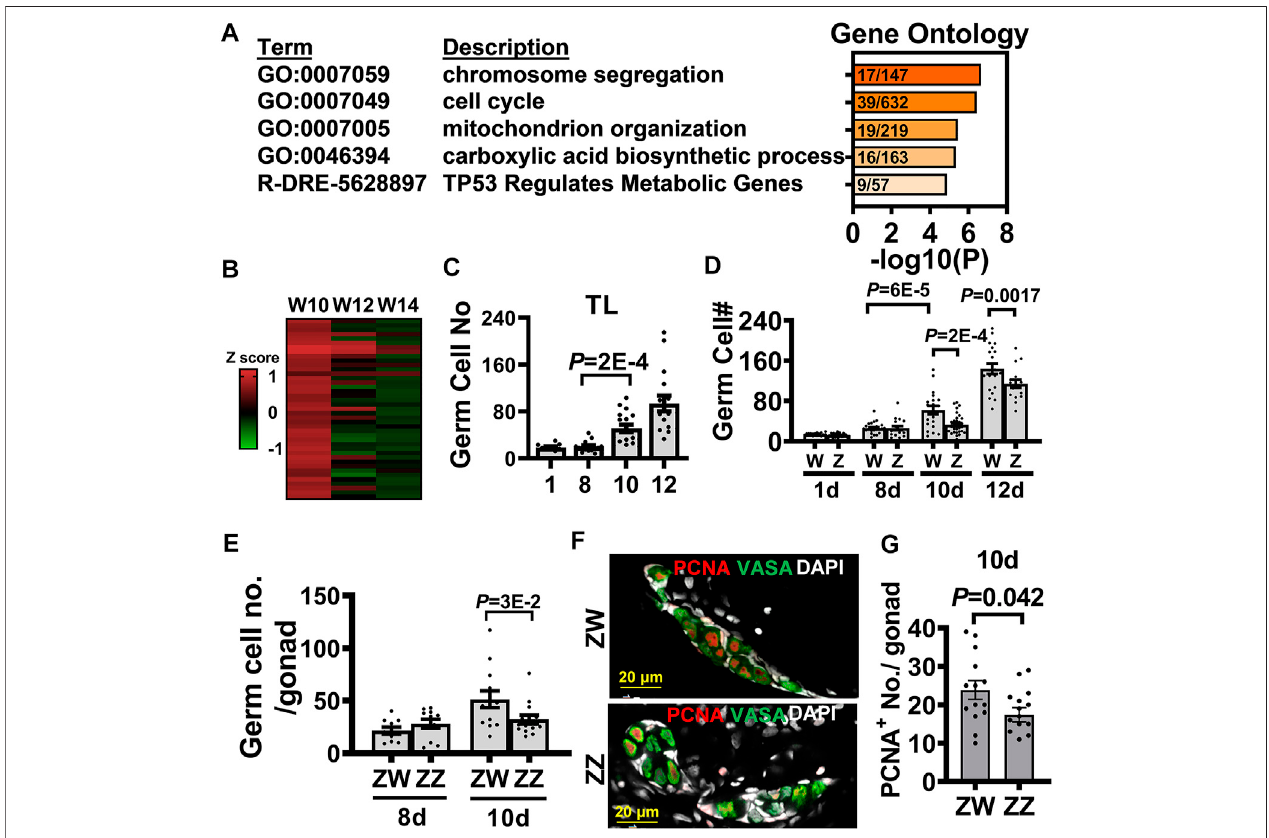
FIGURE 6 | Transcriptome analysis of 10-dpf germ cells identi fi es the advanced germ cell proliferation as a sign of zebra fi sh female differentiation. (A) . Gene ontology analysis of 668 differentially expressed genes (DEGs) upregulated in the 10 dpf W-hybrid. (B) . The heat map of DEGs in the pathways of chromosome segregation (GO:0007059) and cell cycle (GO:0007049) arehigh inthe W-hybridat 10dpf and gradually decreasedat 12and 14dpf.The expression level isnormalized byaz-score (C) .ThegermcellnumbersofTLlaboratorystrainat1,8,10,and12dpf.Germcellssigni fi cantlyproliferateat10dpf. (D) .ThegermcellnumbersofW- andZ-hybridbecomedifferentfrom10dpfon. (E) .GermcellnumberinZWgenotypeofNadiaishigherthanthatinZZgonadat10dpf. (F) .Doubleimmuno fl uorescence showing PCNA staining for proliferating germ cell and Vasa (green) for germ cells. DAPI staining is white for nuclei. (G) . Quantitation of PCNA + -germ cells, showing ZW gonads contain more proliferating germ cells than ZZ gonads at 10 dpf. One dot represents data from one gonad. The two-tailed and unpaired student t -test used for statistical